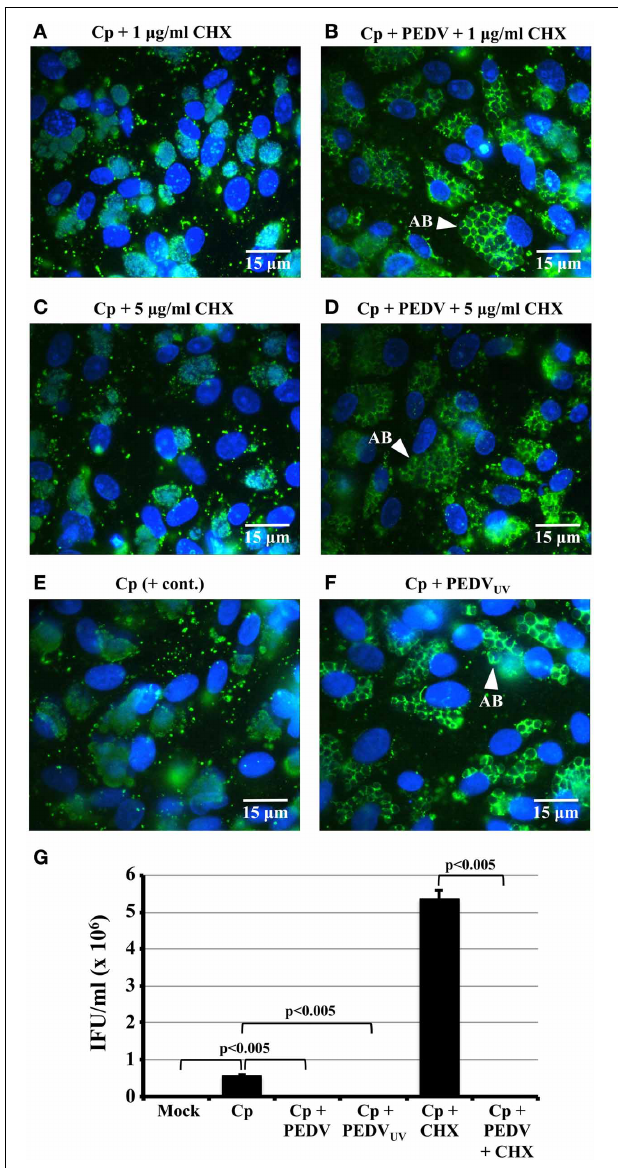
FIGURE 2 | PEDV viral replication is not required for PEDV interference with C. pecorum development. (A–F) Vero cells were mock-infected (Mock), mono-infected with C. pecorum (Cp), infected with C. pecorum and PEDV (Cp + PEDV), or infected with C. pecorum and PEDV UV (Cp + PEDV UV ) as diagrammed in Figure 1A . In some cases, the cells were pre-exposed to either 1 or 5 μ g/ml CHX to prevent PEDV replication, as indicated. At 24 hpvi, replicate coverslips were fixed, and labeled with anti-chlamydial LPS (green) and DAPI (blue) or anti-PDVM protein and DAPI. Quantification of PEDV positive cells and syncytia from this experiment is shown in Figure 1F . Representative fields at 1000 × magnification are shown with 15 μ m scale bars. White arrows indicate anti-LPS-staining AB. (G) Replicate cultures from the co-infections in (A–F) were subjected to sub-passage titer analysis. Some monolayers were pre-exposed to 5 μ g/ml CHX ( + CHX samples) as previously described. Inclusion counts were used to calculate inclusion forming units (IFU)/mL (Y-axis). The average from three biologic replicates ± s.e.m. is shown and the data are representative of three independent experiments. Statistical comparisons are indicated by brackets and were all significant to p ≤ 0 .